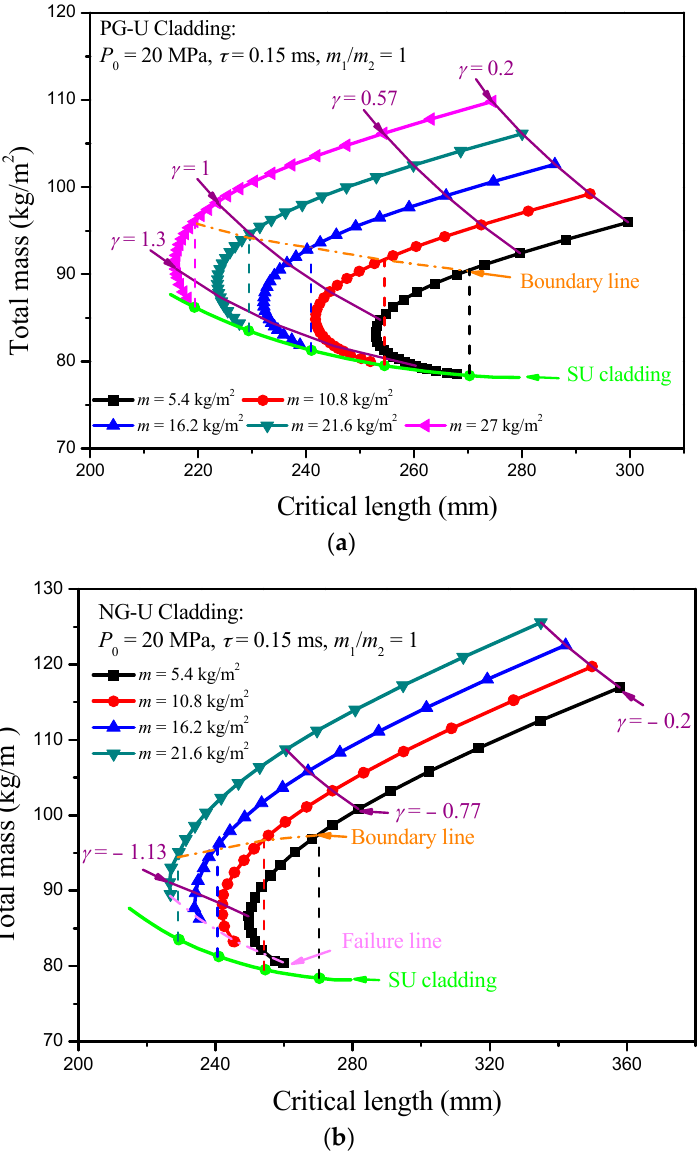
Figure 7. The total mass—critical length figure for ( a ) PG-U cladding and ( b ) NG-U cladding.